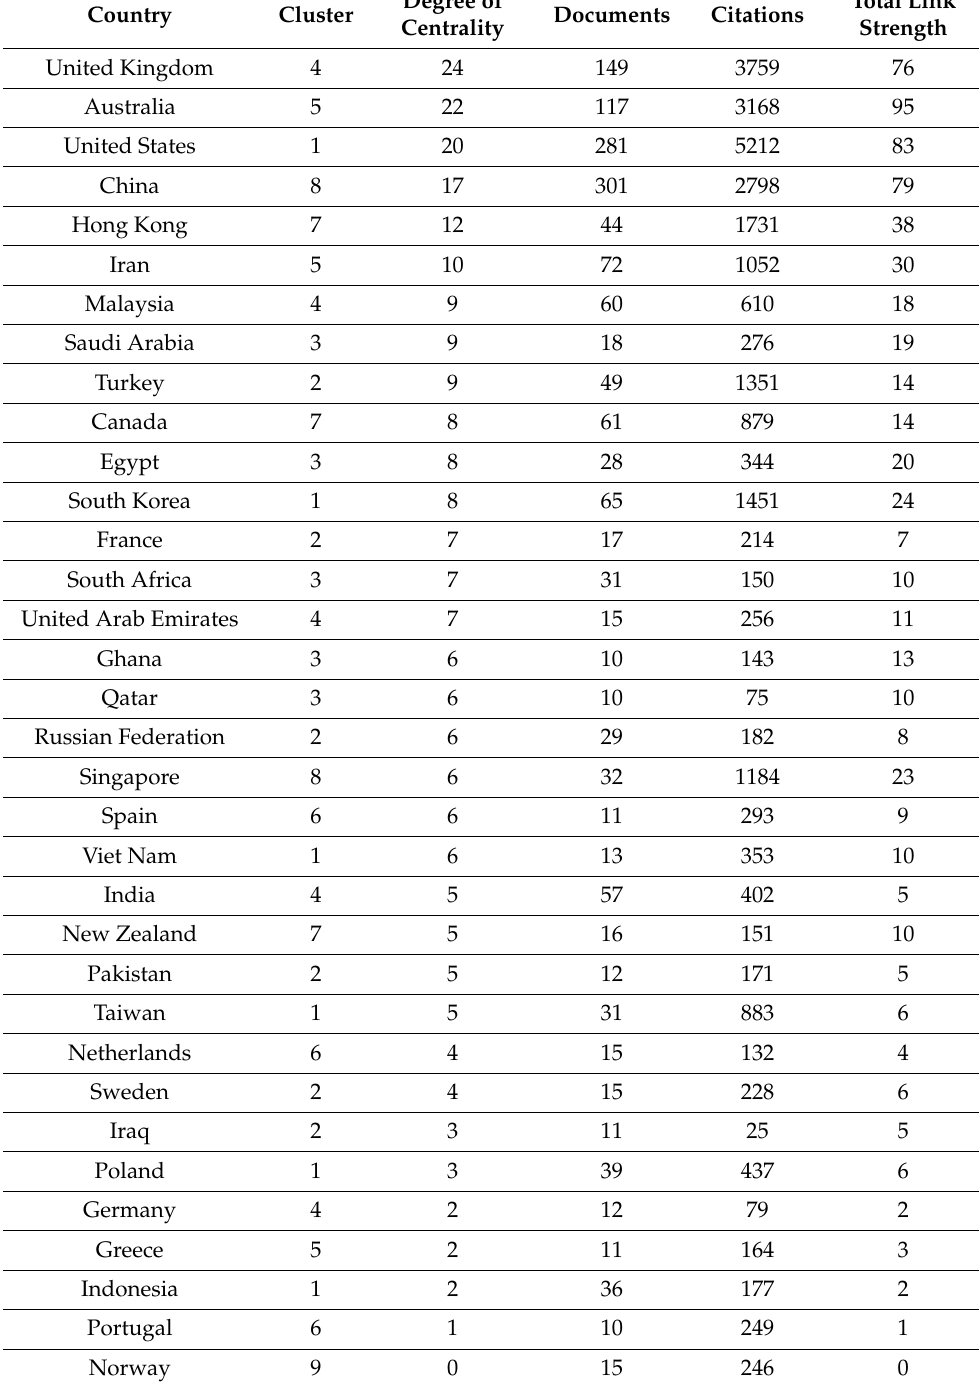
Figure 5. As shown in Table 2, the five topmost active authors based on the number of their publications are Dikmen I., Wang Y., Birgonul M.T., Han S.H., and Fayek A.R. with 19, 17, 16, and 13 publications, respectively. Table 1. Most productive countries in risk management in